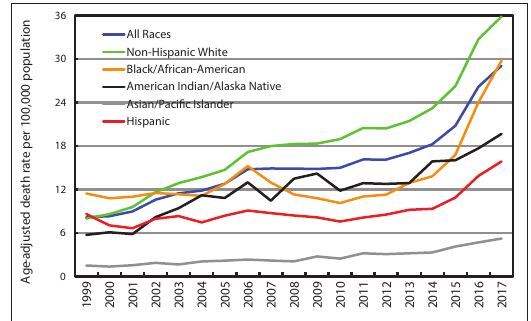
Figure 3: Racial/Ethnic Trends in Drug Overdose Mortality, Males, United States, 1999-2017 Source: Data derived the National Vital Statistics System, Nation - al Mortality